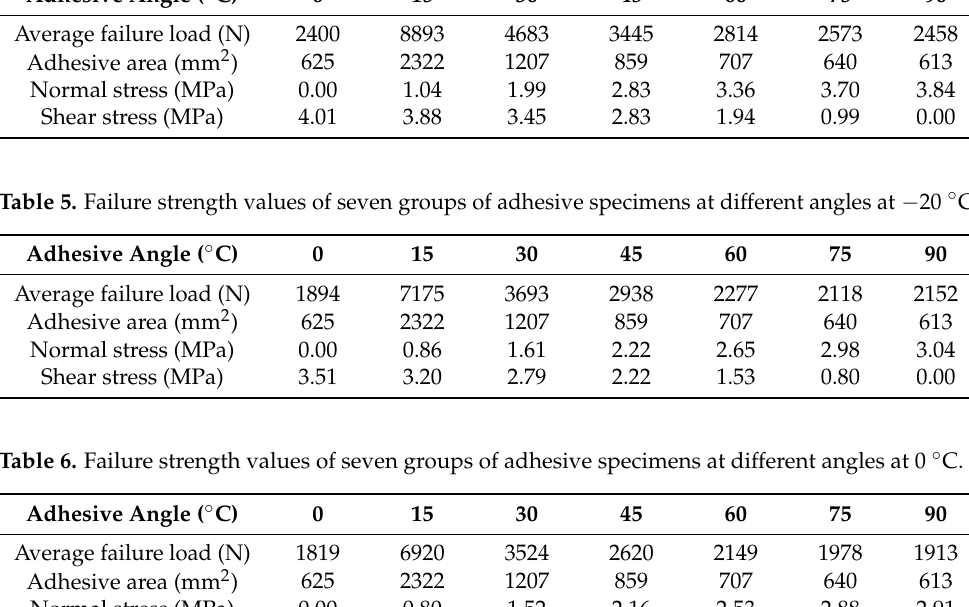
Table 4. Failure strength values of seven groups of adhesive specimens at different angles at − 40 ◦ C. Adhesive Angle ( ◦ C)